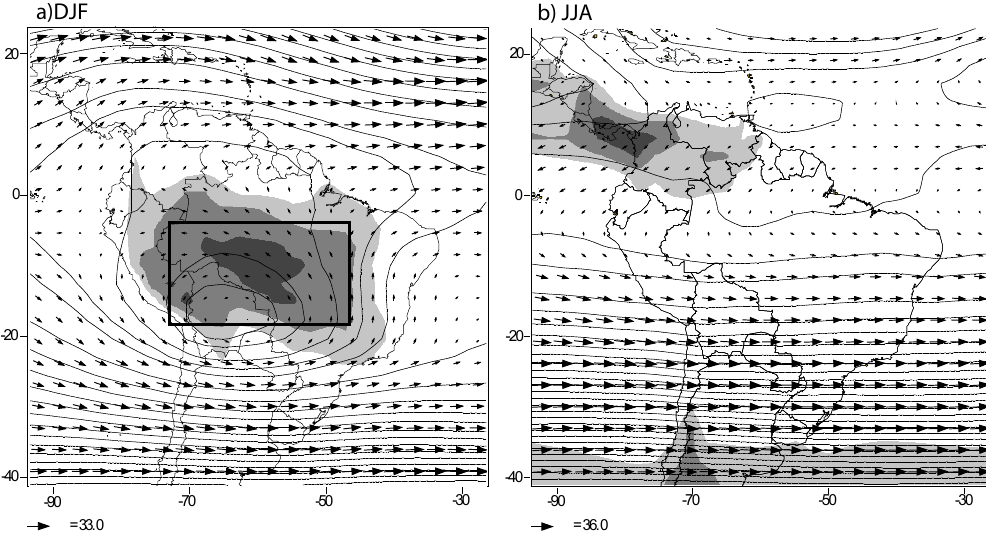
Fig. 1. Long-term mean 200hPa wind and geopotential height and outgoing long-wave radiation based on NCEP/NCAR reanalysis and NOAA-OLR data for (a) austral summer (December–February, DJF) and (b) winter (June–August, JJA). Contour interval is 25gpm, 10gpm above 12400 and 5gpm above 12430. Light, medium, and dark shades indicate OLR values less than 225, 210, and 195Wm − 2 . Black rectangle in (a) denotes region of strongest convective activity during DJF used to create monsoon index M